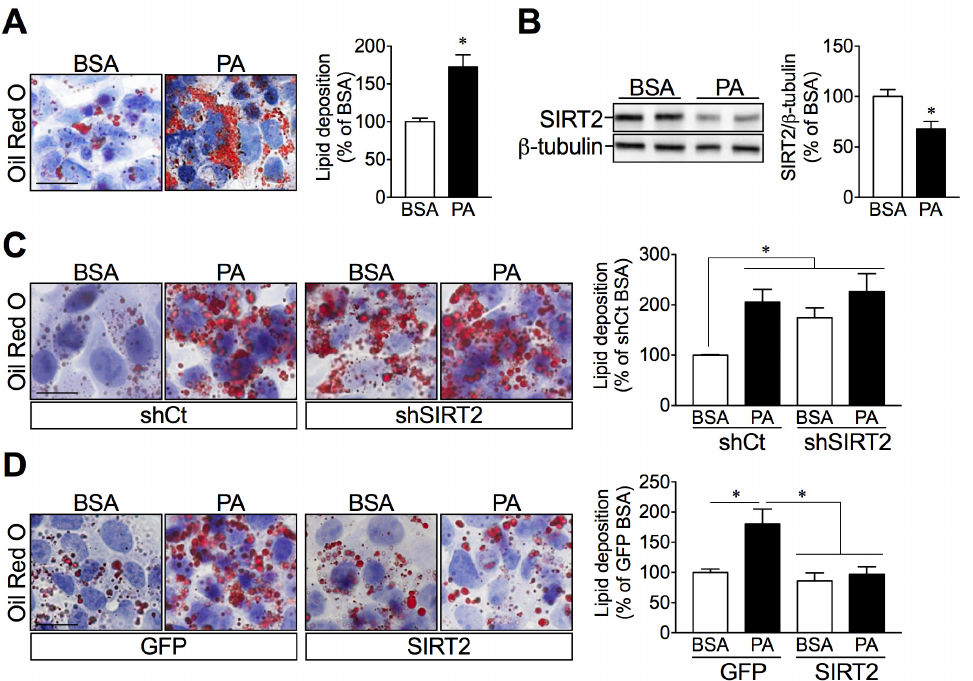
Figure 4. Palmitate and SIRT2 silencing promote lipid accumulation in HepG2 cells, while SIRT2 over- expression attenuates palmitate-mediated lipid deposition. ( A ) HepG2 cells were incubated with BSA (vehicle) or palmitate (0.5 mM) for 24 h. Representative images of ORO-stained HepG2 cells and quan- tification of ORO-stained lipid droplets by spectrophotometric analysis after isopropanol extraction. ( B ) Representative Western blots of SIRT2. SIRT2 levels were normalized to the levels of β -tubulin in the same lane. ( C , D ) Images of ORO-stained HepG2 cells infected with lentiviruses expressing either a short hairpin for control (shCTRL) and SIRT2 (shSIRT2) to silence SIRT2, as well as a vector with GFP sequence (GFP) and SIRT2 sequence (SIRT2) for the overexpression. These cells were incubated with either BSA or palmitate for 24 h and spectrophotometric analysis of stained lipids. (scale bar = 50 μ m). Results are presented as mean ± SEM; n = 3 per group; * p < 0.05.